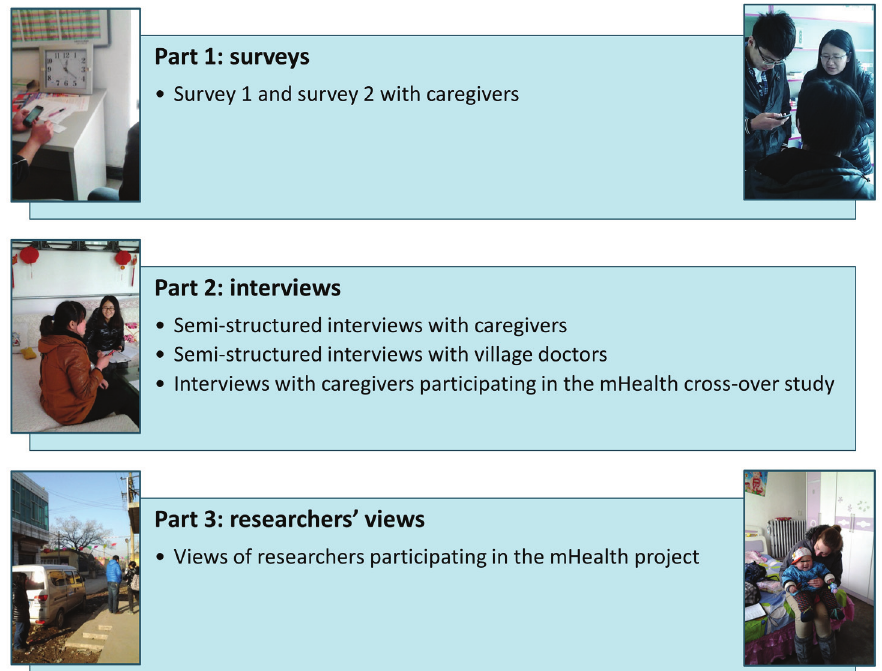
Figure 2. Overview of mixed methods study. Photographs are the courtesy of Michelle Helena van Velthoven and Wei Wang, personal